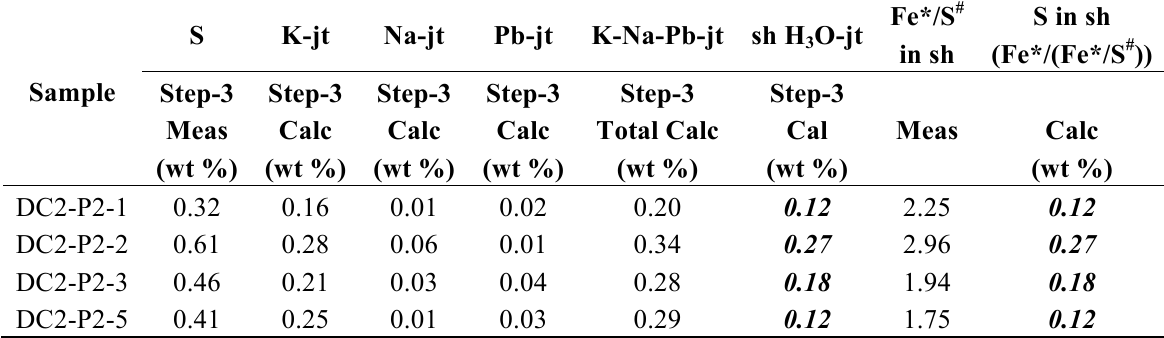
Table 2. Stoichiometric calculations (Calc) of S in K, Pb, and Na jarosites (jt) according to the measured (Meas) K, Pb, and Na in Step 3 of the sequential extractions from samples and Na jarosites is compared with the total S measured in Step 3; the difference (in bold) represents the S from schwertmannite or H3O-jt in Step 3. Results in italic represent the S content measured derived from the schwertmannite